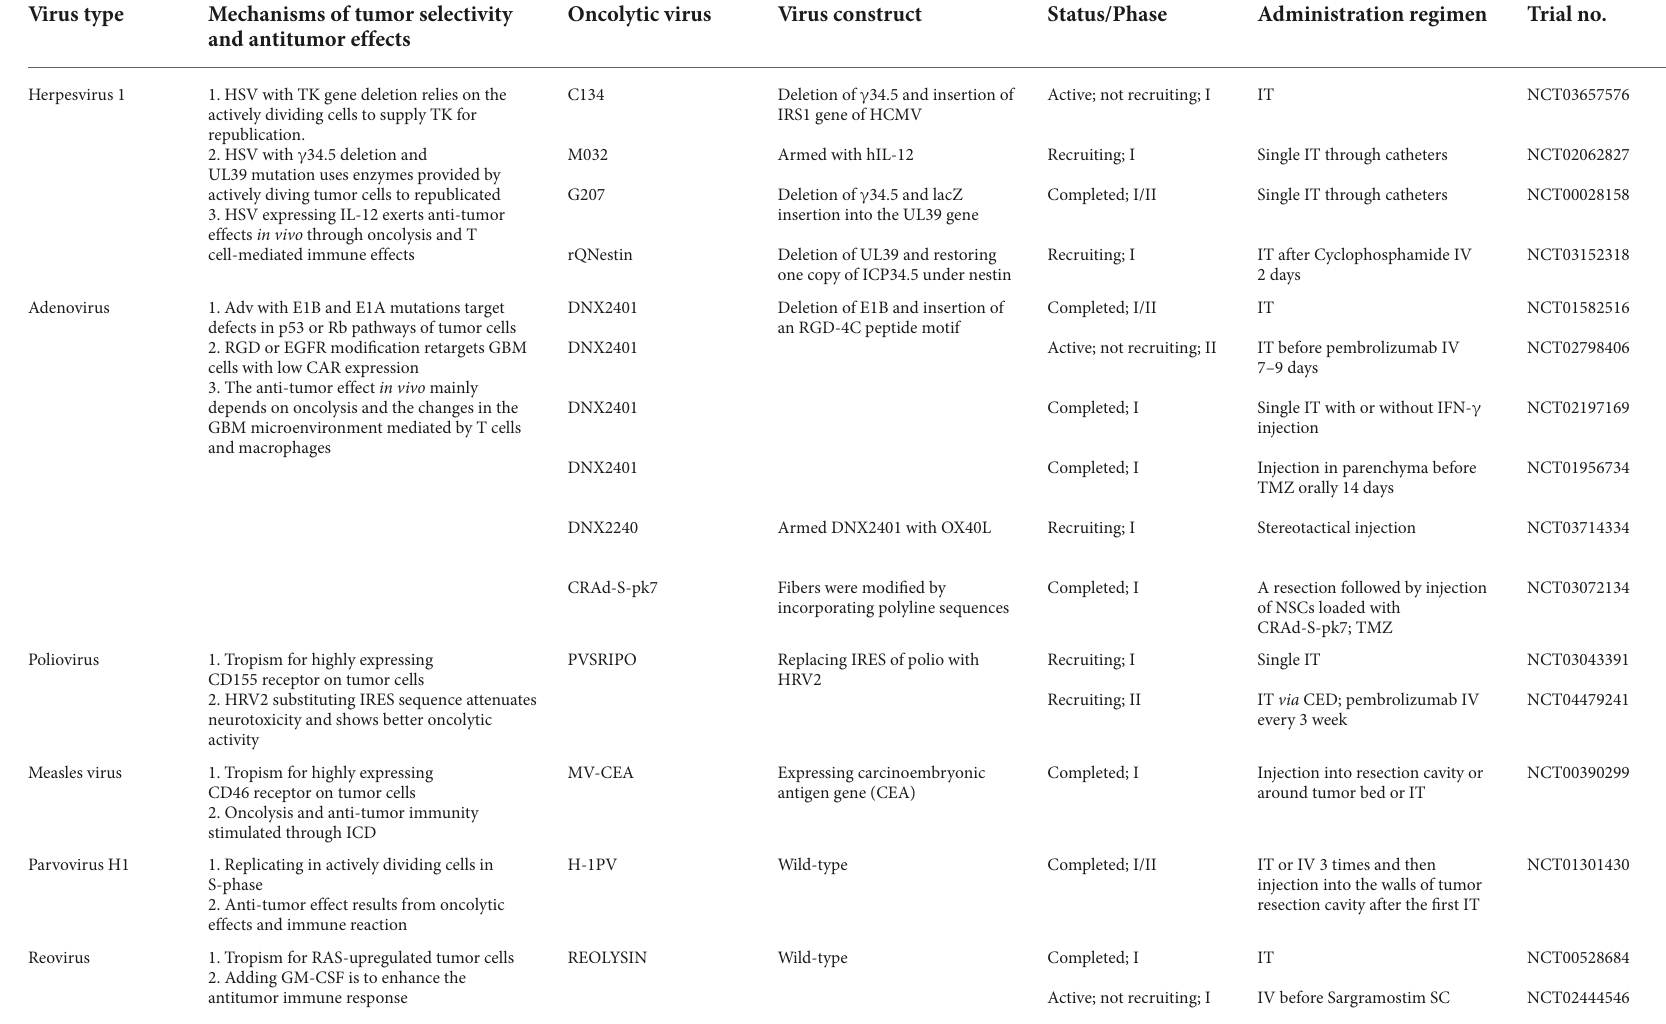
TABLE 2 Ongoing or completed clinical trials of OVs against